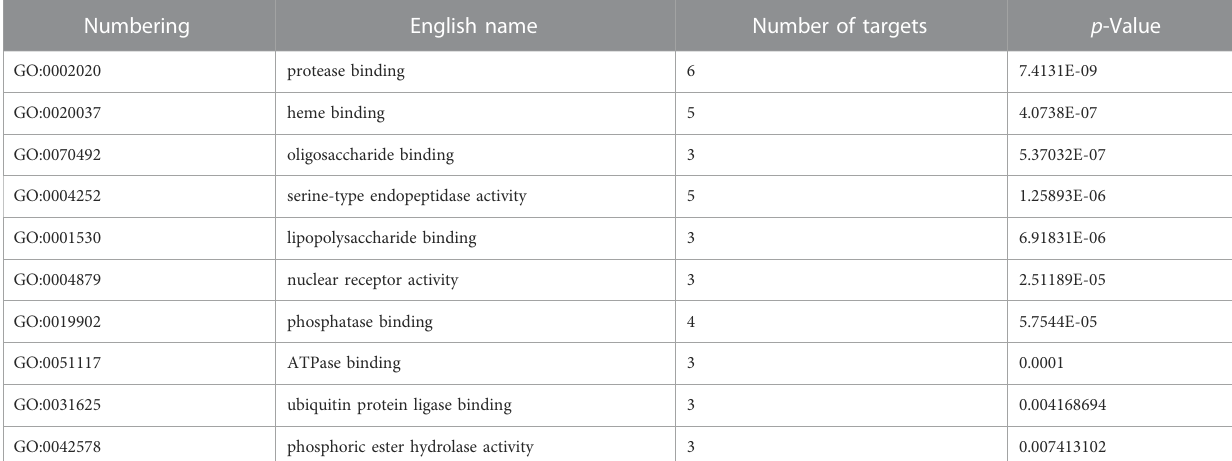
TABLE 6 Results from GO molecular function.